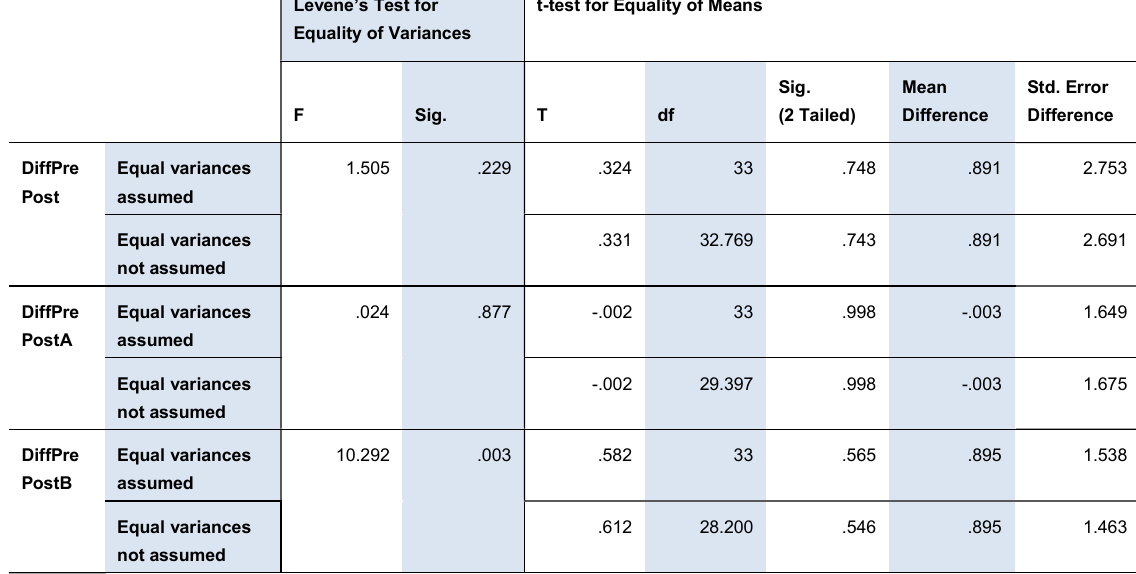
Levene’s Test for Equality of Variances